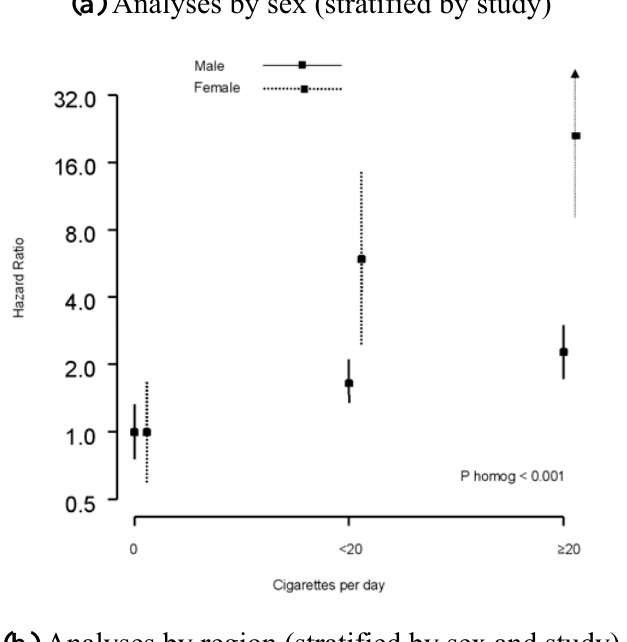
Figure 2. Hazard ratios for death due to upper aero digestive tract cancer for current smokers by number of cigarettes smoked per day, compared with those who have never smoked. Lines show 95% confidence limits; the arrow signifies that the upper end is off the scale. Hazard ratios are adjusted for age and